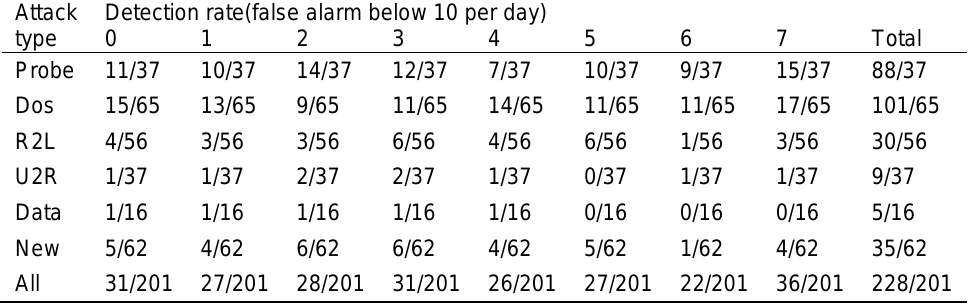
Table 1 5-tuple configuration load balancing